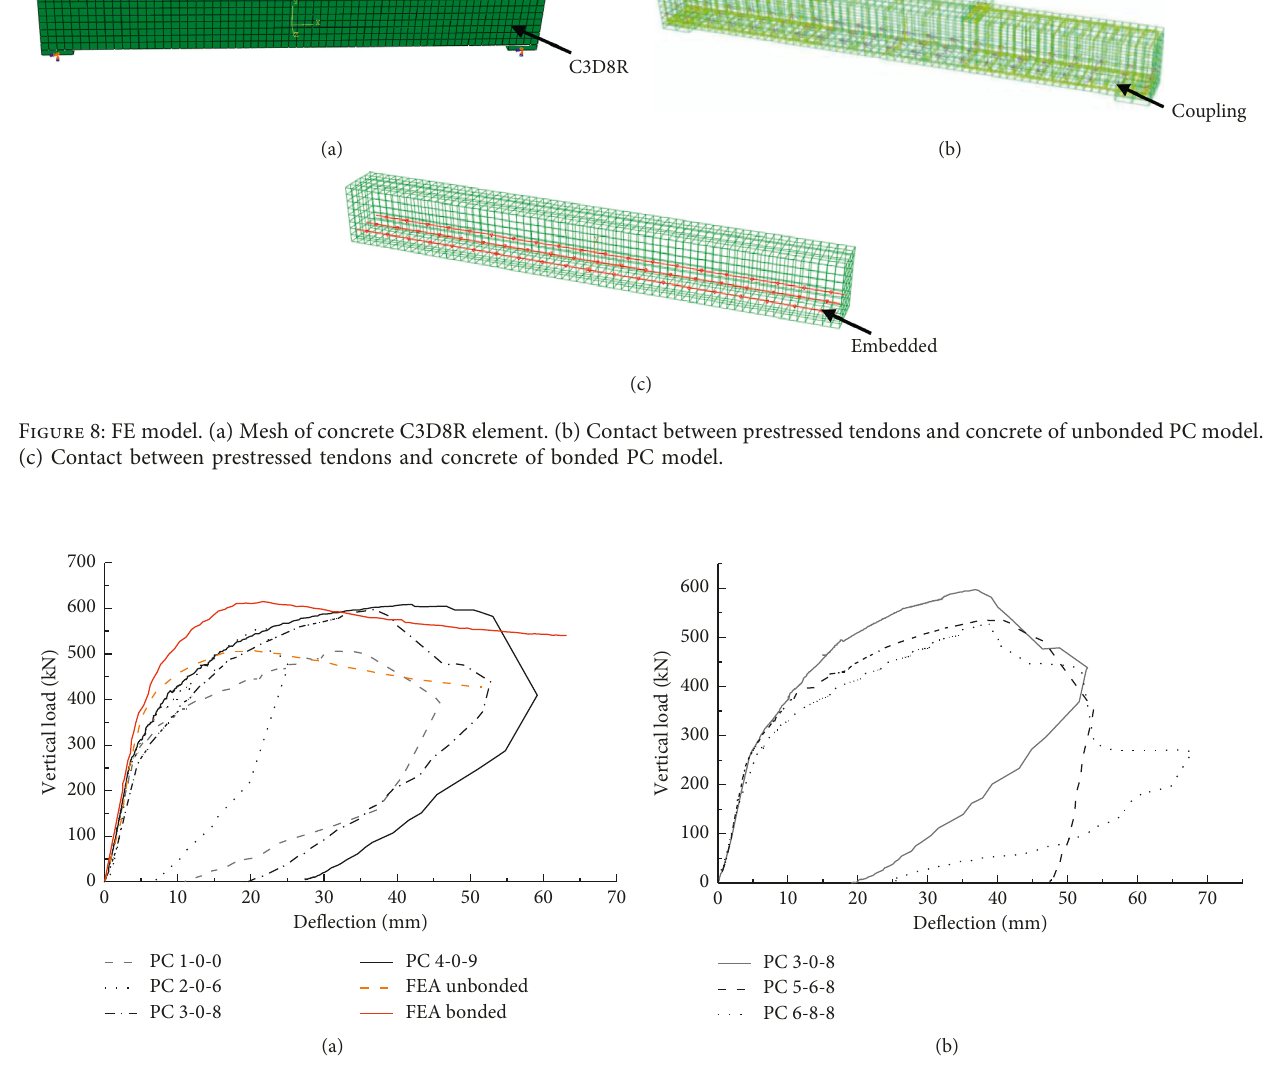
Figure 9: Vertical load-deflection curves. (a) Influence of the degree of curing of the retarder. (b) Influence of tensile period on prestressed tendons. Table 2: Cracking load, maximum bending strength, and residual deformation of PC girders.